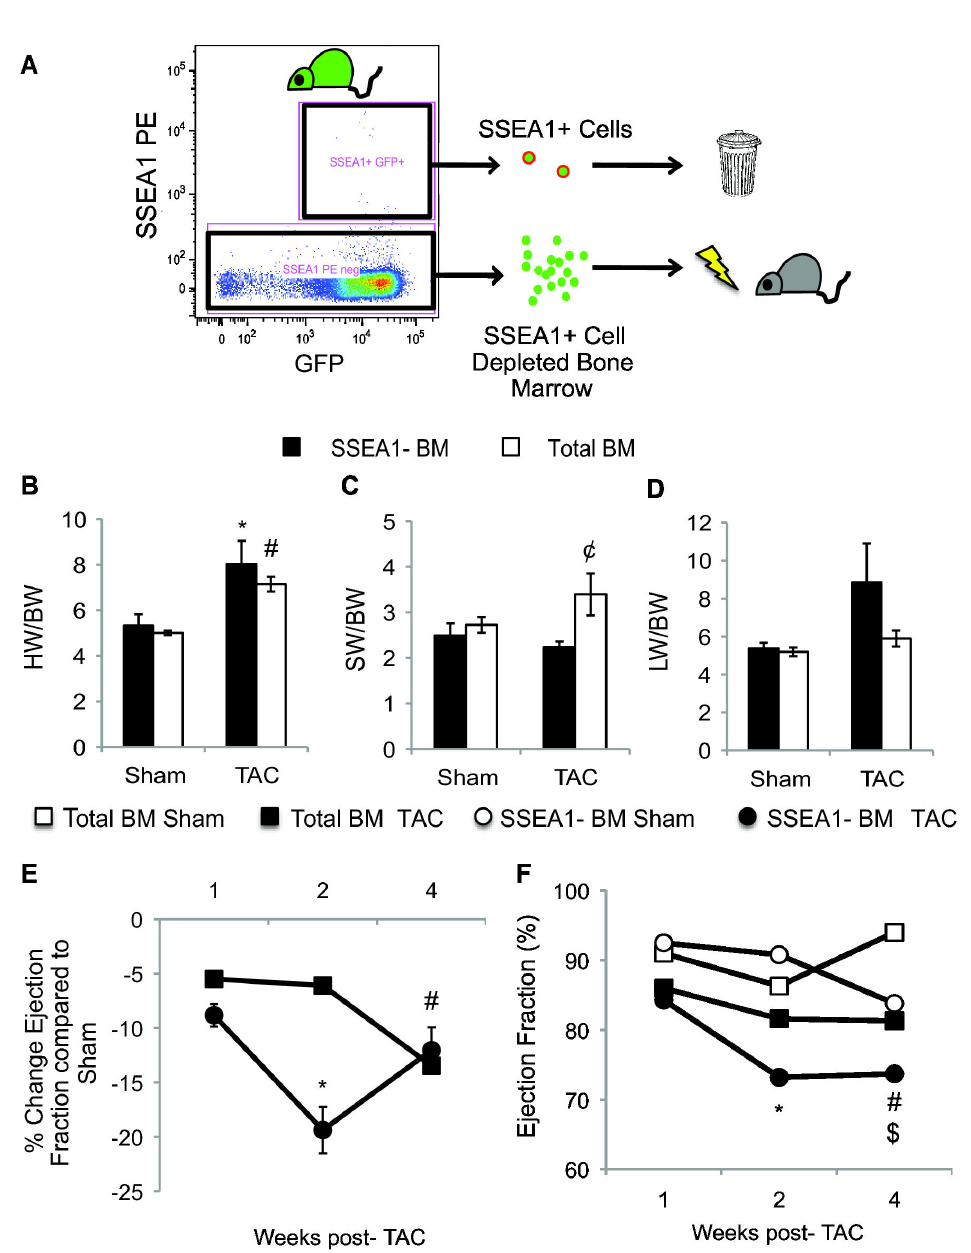
Figure 2. Bone Marrow SSEA1+ Cell Depletion Accelerates Cardiac Remodeling after TAC. (A) Experimental Protocol. SSEA1+ cells (green circles with red outline) were depleted from the total bone marrow of GFP transgenic mice by FACS and transplanted into lethally irradiated C57 mice (grey; SSEA1-BM). Control mice were transplanted with total GFP bone marrow (total BM). (B) Four weeks after TAC, the heart weight (HW/BW) was increased in both SSEA1-BM (black bars) and total BM (white bars) groups. (C) After TAC, the spleen weight (SW/BW) in SSEA1-BM mice was significantly lower compared to mice with total BM. (D) Measurement of lung weight (LW/BW) 4 weeks post-TAC. (E) The ejection fraction of SSEA1-BM mice (black circle) in response to TAC was decreased quicker relative to mice with total BM (black square). (F) The cardiac function of SSEA1-BM sham mice (open circle) decreased over time. Cardiac function of mice with total BM (open square) remained unchanged. n = 4-6. * P < 0.05 compared to SSEA1-BM sham. # P ≤ 0.01 compared to total BM Sham. ¢ P = 0.05 SSEA1-BM TAC versus total BM TAC. $ P = 0.04 SSEA1-BM Sham versus total BM Sham. Abbreviation: SSEA1, stage-specific embryonic antigen 1; TAC, trans-aortic constriction; GFP, green fluorescent protein; FACS, fluorescence-activated cell sorting; SSEA1-BM, SSEA1+ depleted bone marrow; BM, bone marrow; HW, heart weight; BW, body weight; SW, spleen weight; LW, lung weight. doi: 10.1371/journal.pone.0068528.g002 PLOS ONE |